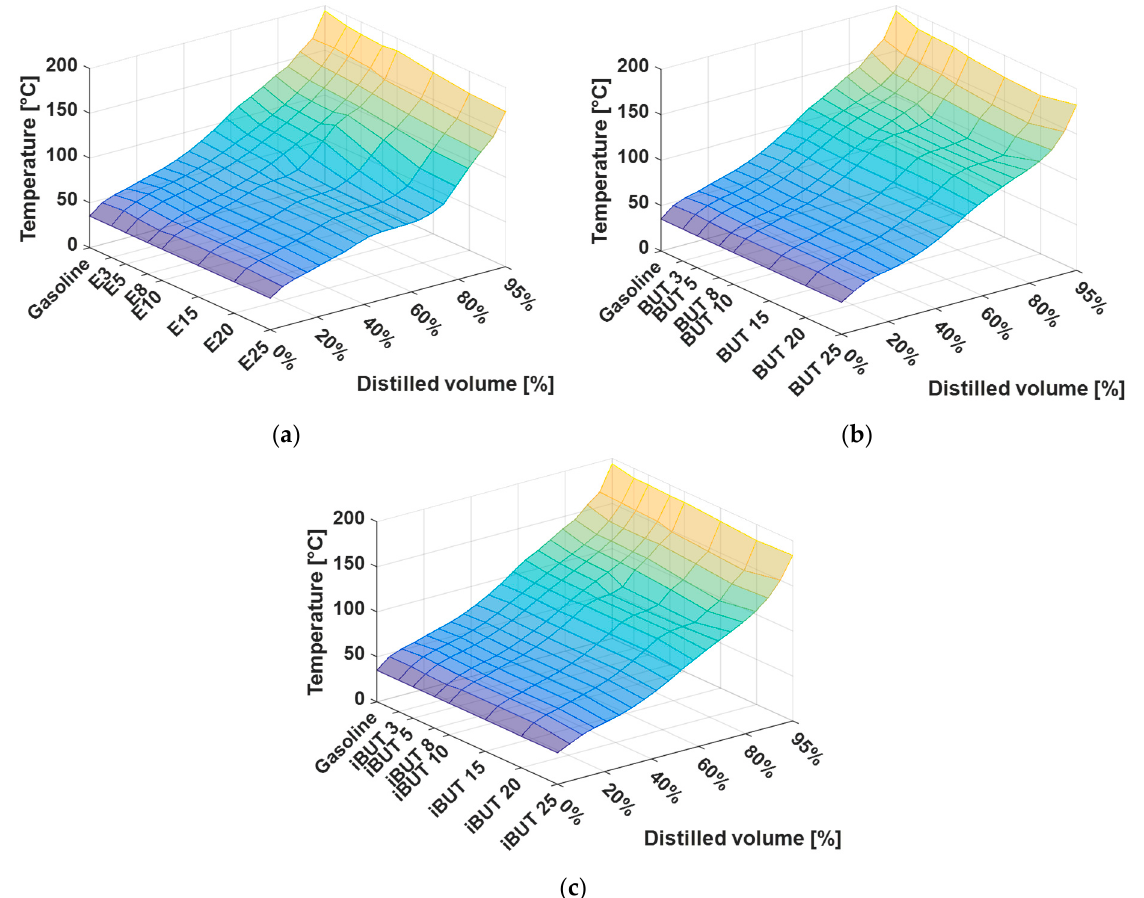
Figure 2. ( a ) Distillation curve of gasoline ethanol mixture; ( b ) distillation curve of gasoline butanol mixture; and, ( c ) distillation curve of gasoline i-butanol mixture.